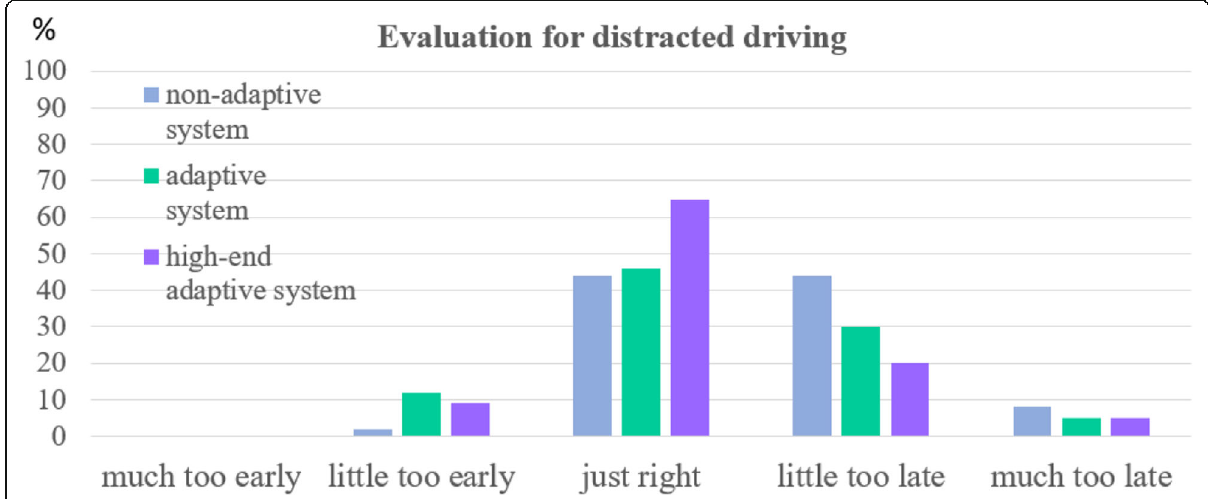
Fig. 10 Evaluation of the warning and intervention times of the three system variants under